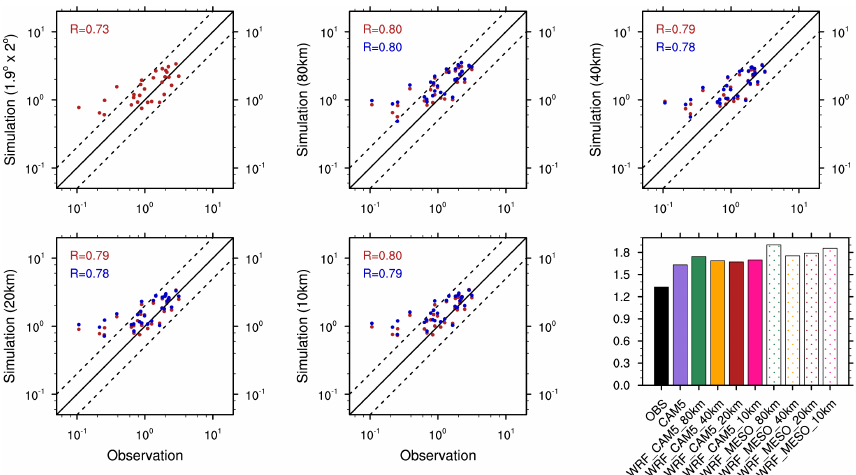
Fig. 14. Scatterplots of the domain mean daily precipitation rate (mm day − 1 ) from model simulations that utilize the CAM5 (red) and WRF (blue) physics suite evaluated against the GPCP daily data averaged over the same